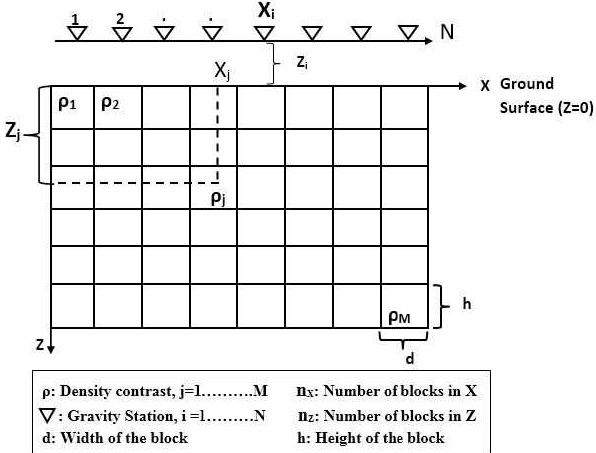
Figure 1. A 2D model of the subsurface under a gravity profile. Gravity stations ( X i ) are located at the centers of the blocks, indi- cated by the (cid:96)